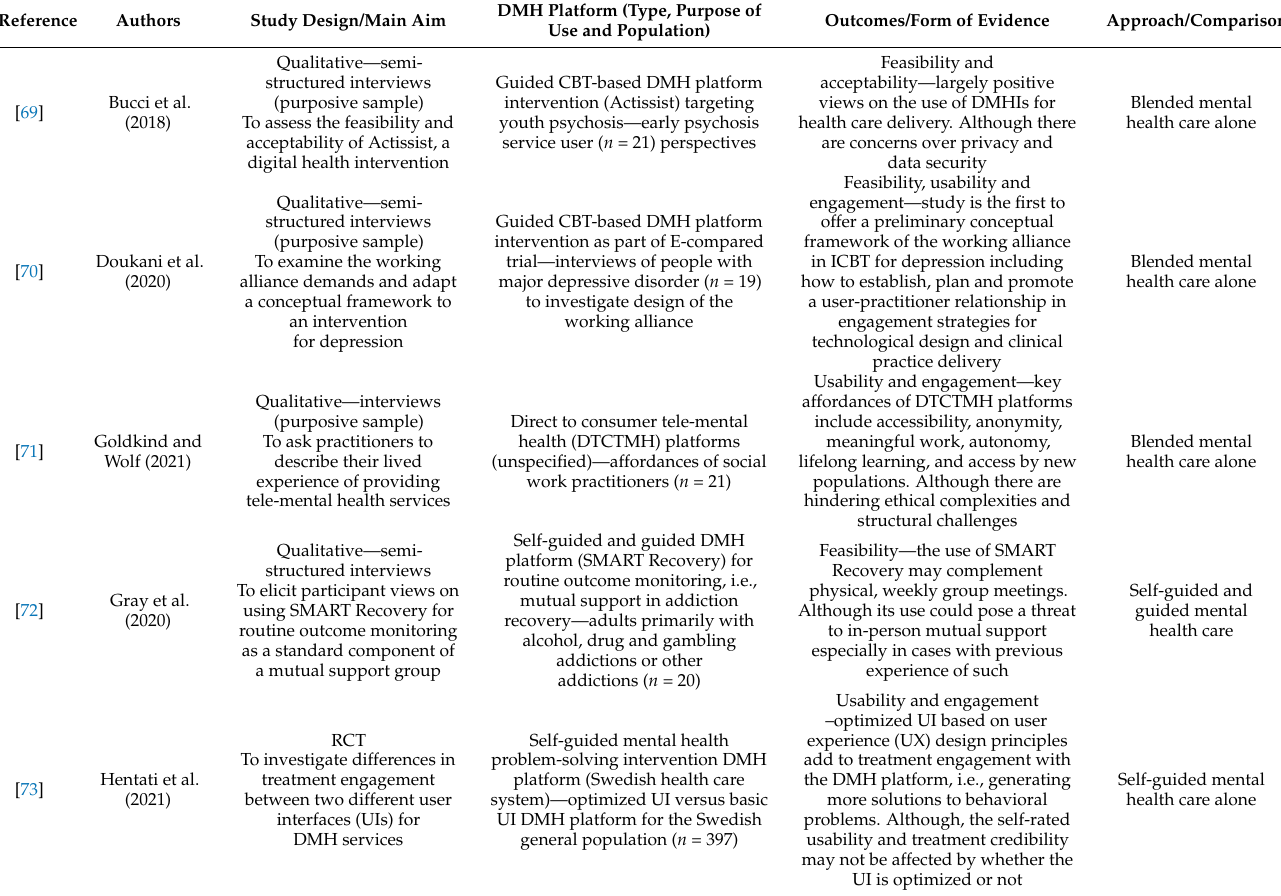
Table 2. Overview of empirical studies that focused on evaluation of the DMHI/s applied on the DMH